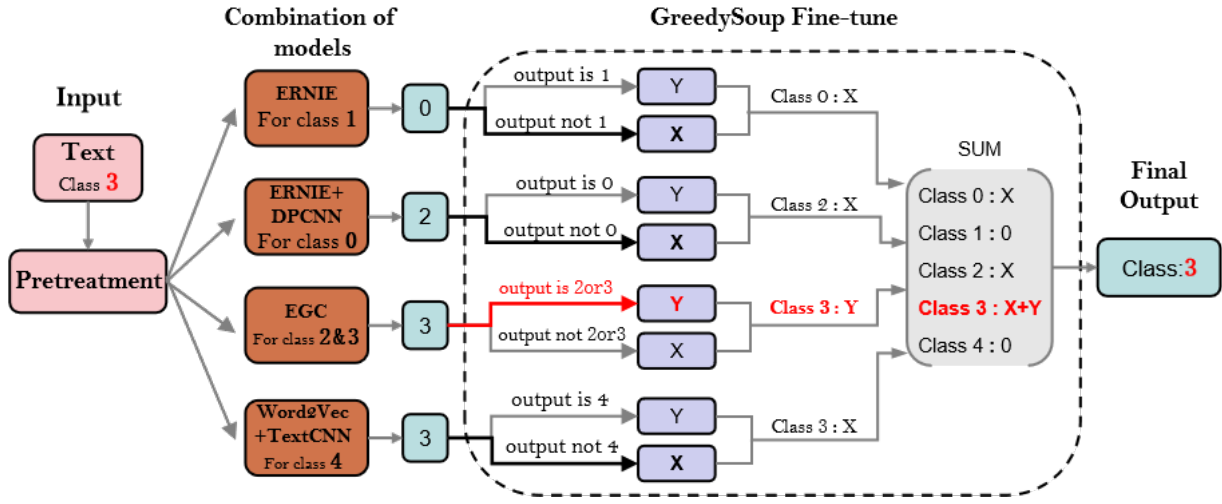
Figure 11. GreedySoup Fine-tune structure, showing the processing of data in the GreedySoup Fine-tune stage.